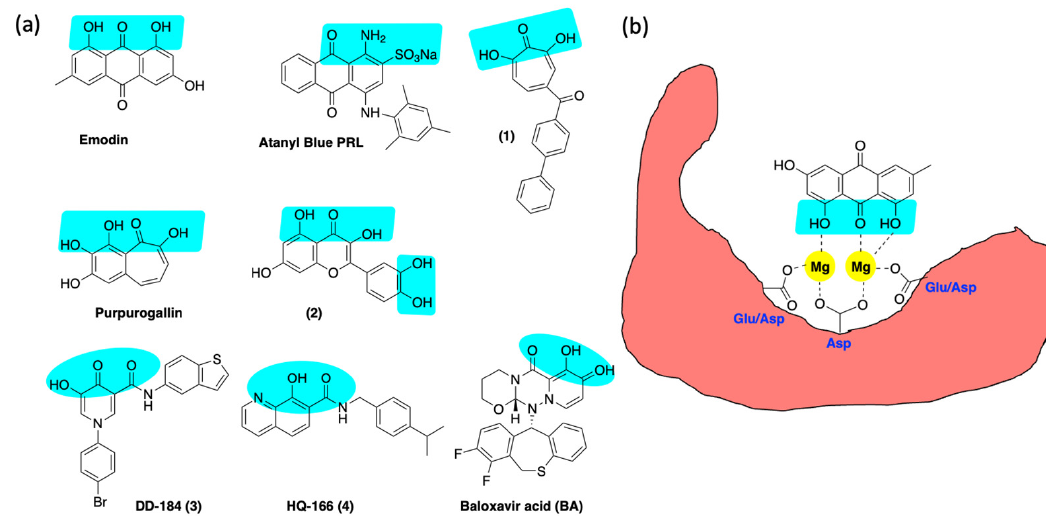
Figure 5. ( a ) Reported inhibitors of HSV exonucleases. Putative magnesium-binding functionality is highlighted in blue. ( b ) Hypothetical interactions between the inhibitor emodin and the TMID active site highlighting direct interactions between the anthraquinone oxygens and the bound magnesium ions.